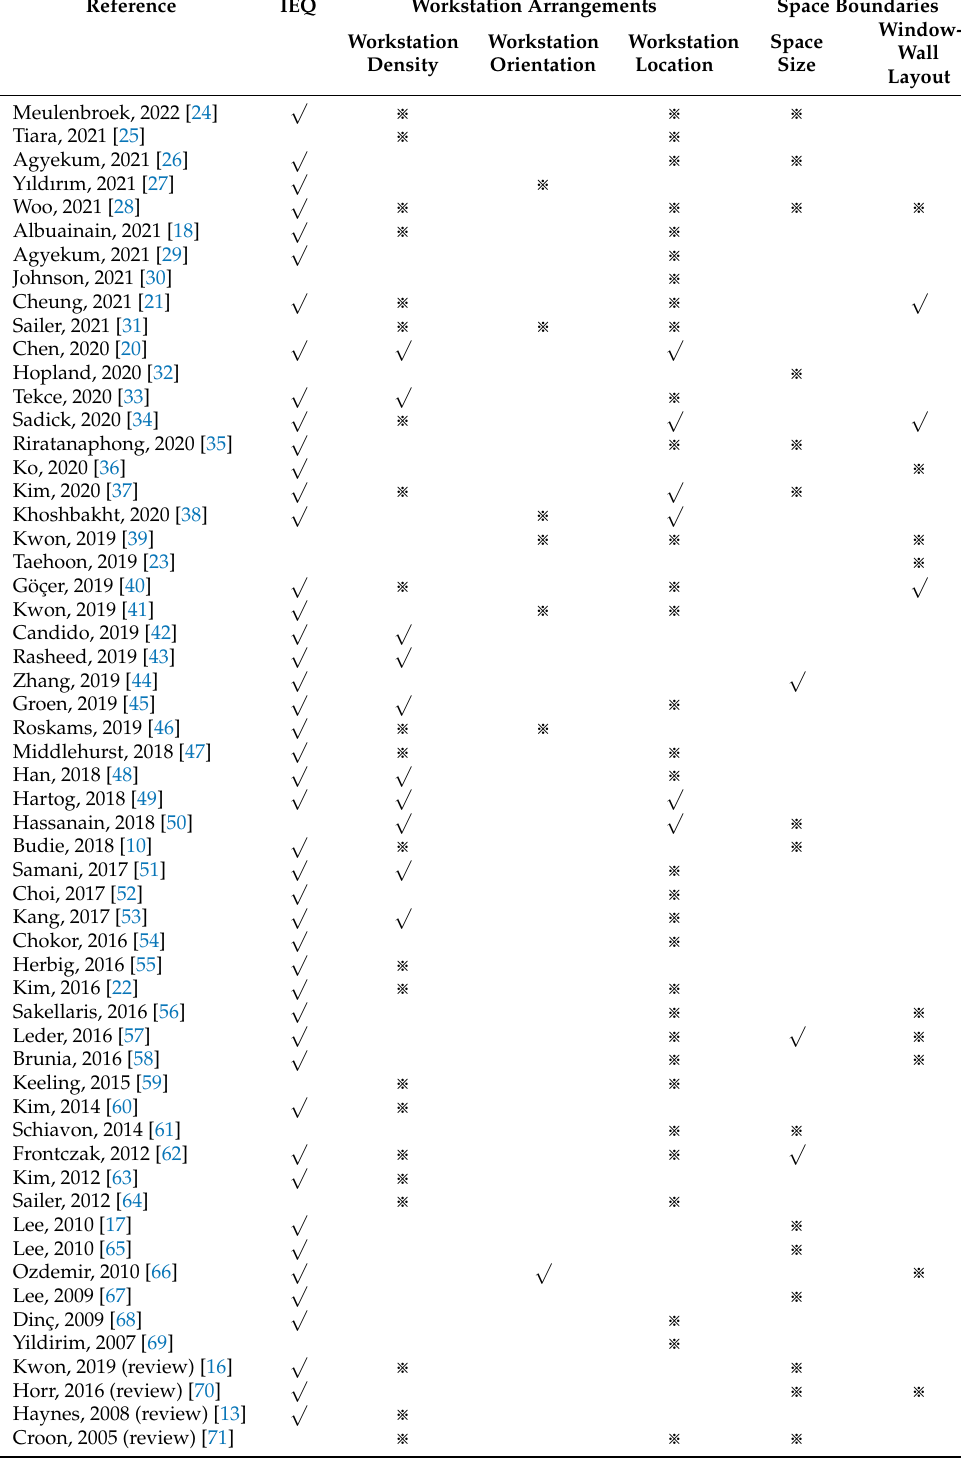
Table 2. Basic information and factor coverage status of the selected articles. Reference IEQ Workstation Arrangements Space Boundaries